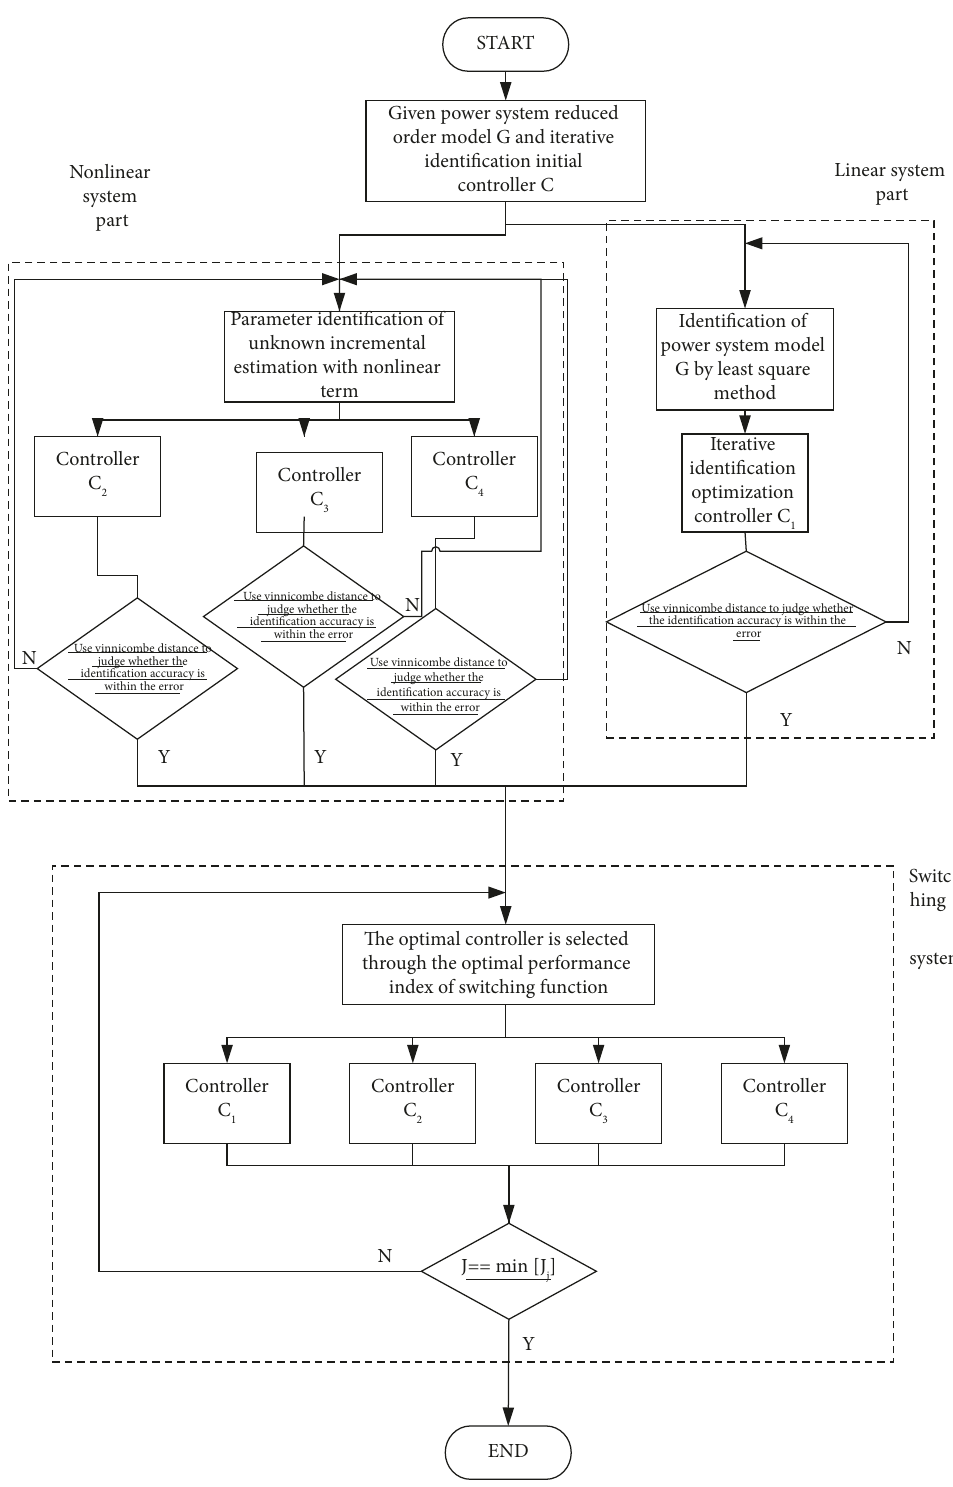
Figure 3: Overall control flow